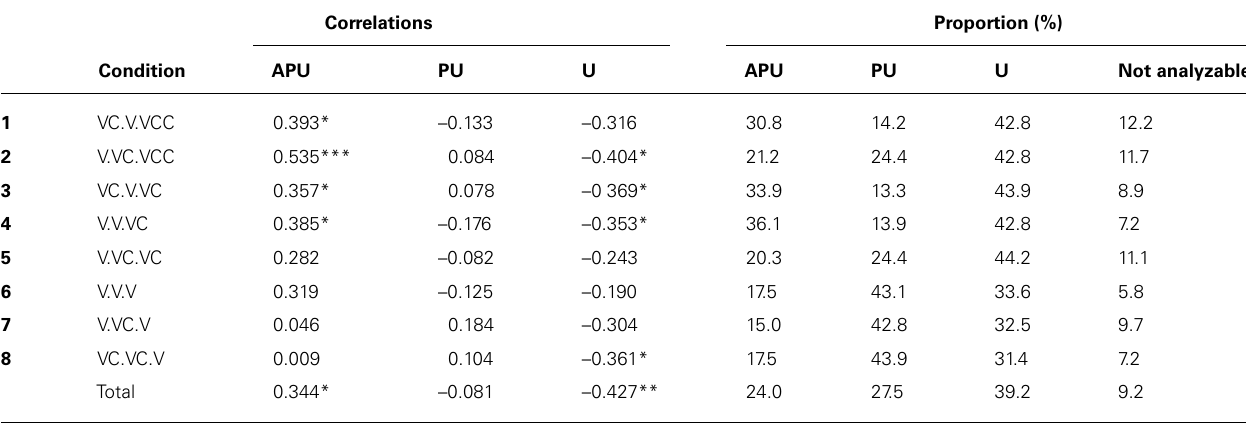
Table 1 | Results as a function of structural conditions. Correlations Proportion (%) Condition